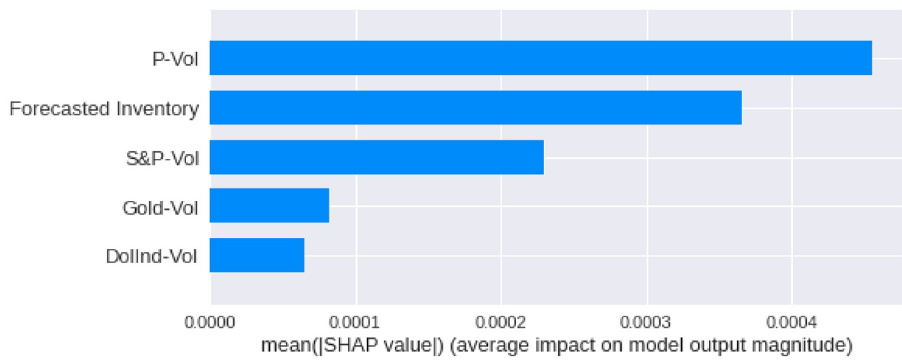
Fig 22. Mean Shapley values for the fourth previous day using Nadam optimizer.